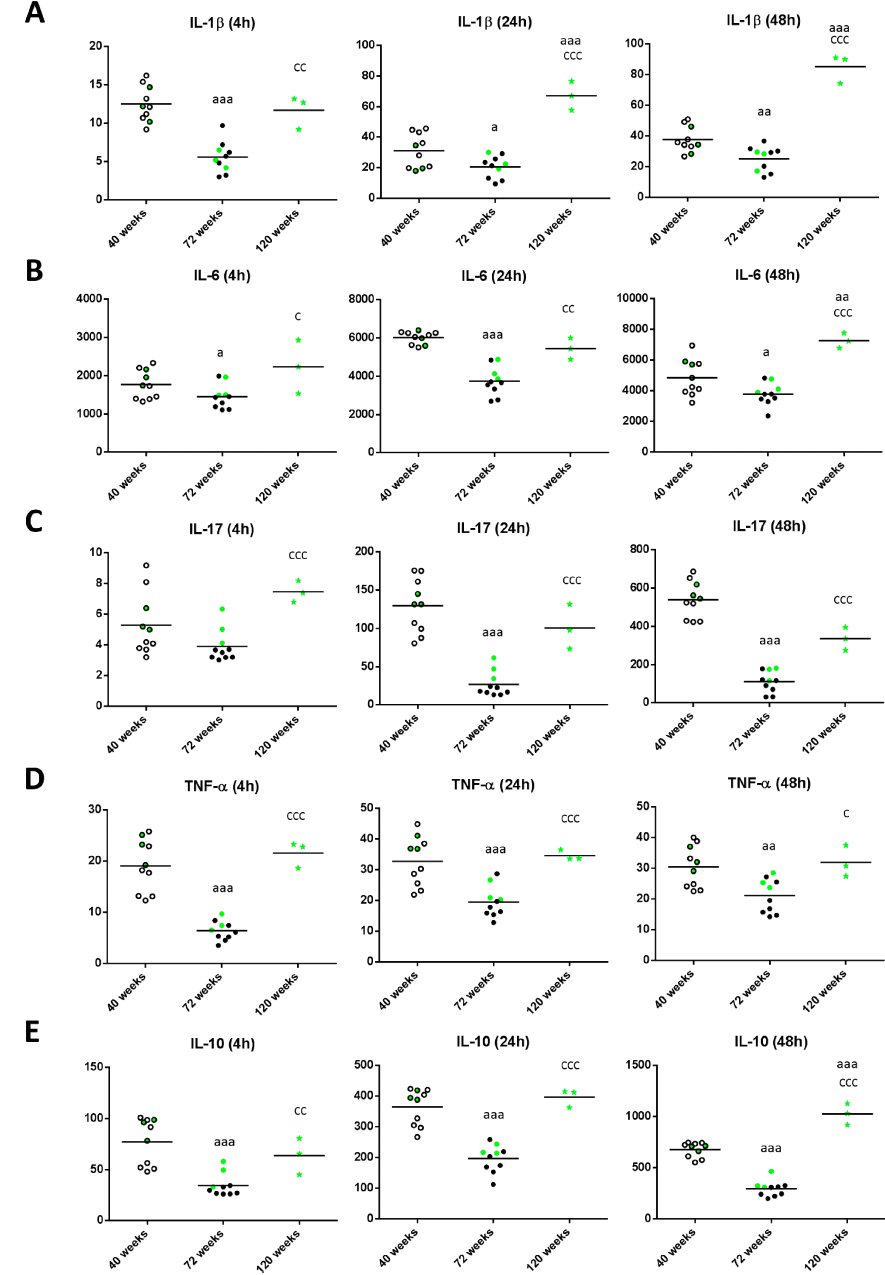
Figure 3. Levels (pg/mL) of IL-1 β ( A ); IL-6 ( B ); IL-17 ( C ); TNF- α ( D ) and IL-10 ( E ) released by peritoneal leukocytes of adult (40 weeks), old (72 weeks) and long-lived (120 weeks) mice, after 4, 24 and 48 h of culture in presence of Con A (1 µ g/mL). The green points represent the values in mice that reached 120 weeks. a: p < 0.05; aa: p < 0.01; aaa: p < 0.001 with respect to the value in adult mice. c: p < 0.05; cc: p < 0.01; ccc: p < 0.001 with respect to the value in old mice.